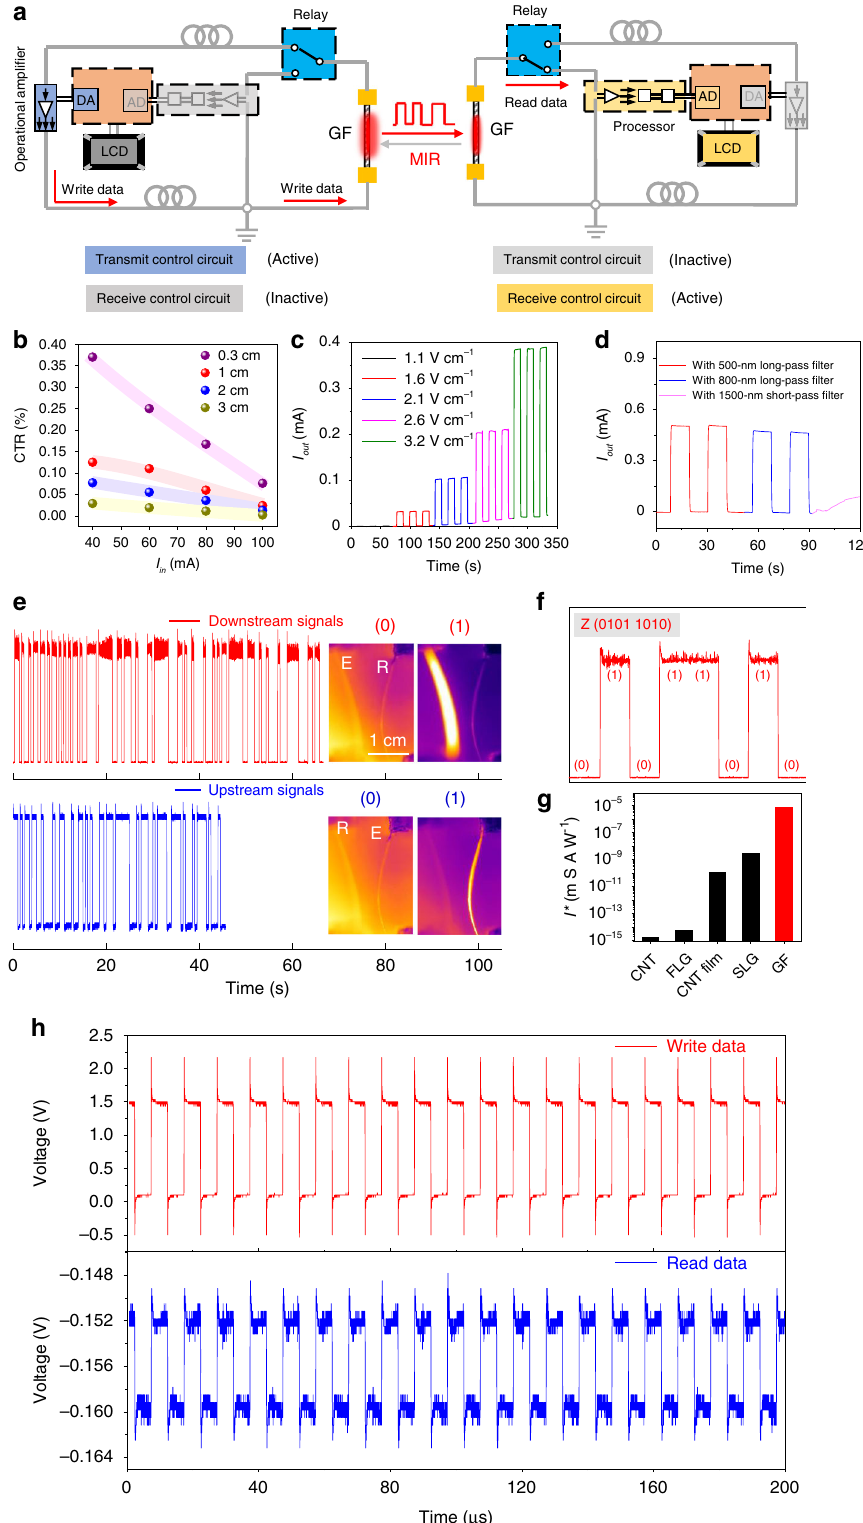
machine. Flexible GO belts were processed into continuous graphene oxide fi bers (GOFs) on a twist-draw apparatus, where a normal torque was applied to twist GO belts into a thread-like structure. After undergoing air drying, the twisted fi bers were thermally treated in a vacuum oven for 2 h at 60 °C to remove residual solvents. GOFs were insulating, which were reduced into highly electrically conductive optoelectronics by chemical and thermal treatment at 3100